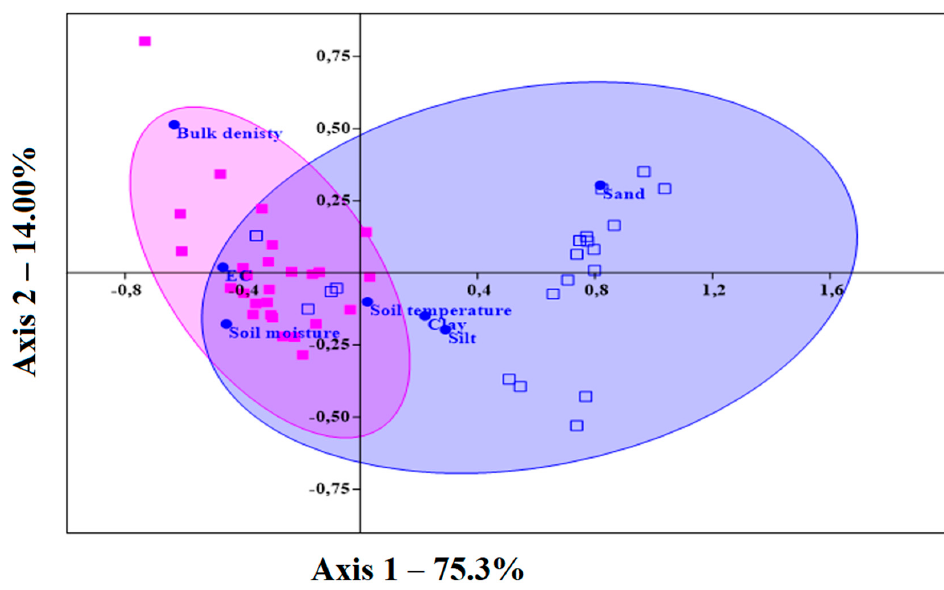
Figure 3. Correspondence analysis (CA). Painted squares show data set for agricultural land, open squares represent sets of points related to forests. Ellipses indicate the 95% confidence level for all factors.